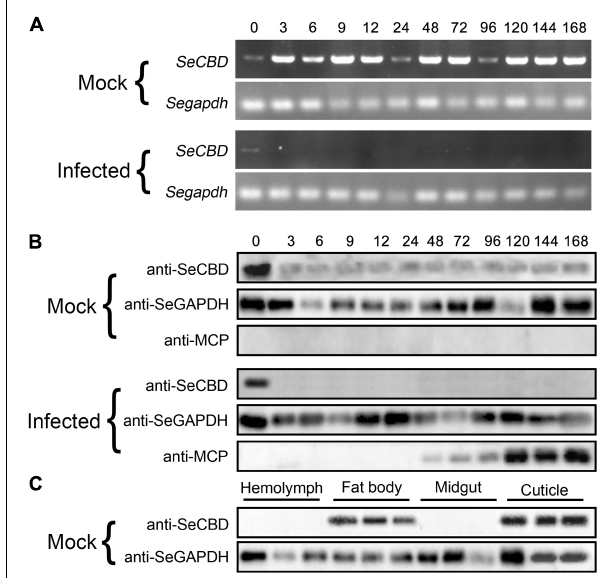
FIGURE 3 | Comparison of SeCBD transcription and expression level in HvAV-3h-infected larvae and mock-infected larvae of Spodopera exigua . (A) SeCBD transcription level detection in HvAV-3h-infected larvae and healthy larvae. (B) SeCBD expression level detection in HvAV-3h-infected larvae and mock-infected larvae. (C) SeCBD expression level detection in healthy larval tissues. Mock, mock-infected larvae; Infected, infected larvae. Error bars represent standard